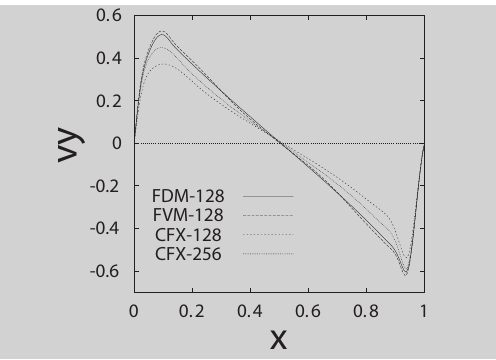
Figure 10: Comparison of profiles of horizontal velocity vx through vertical centerline and vertical velocity vy through horizontal centerline, FVM and FDM on 129 * 129 mesh and CFX on 129 * 129 and 257 using m = 0.0025, n = 1). Figure 11: The flow field in driven cavity using 129 * 129 mesh size using finite difference method (Power Law m = 0.0001, n =